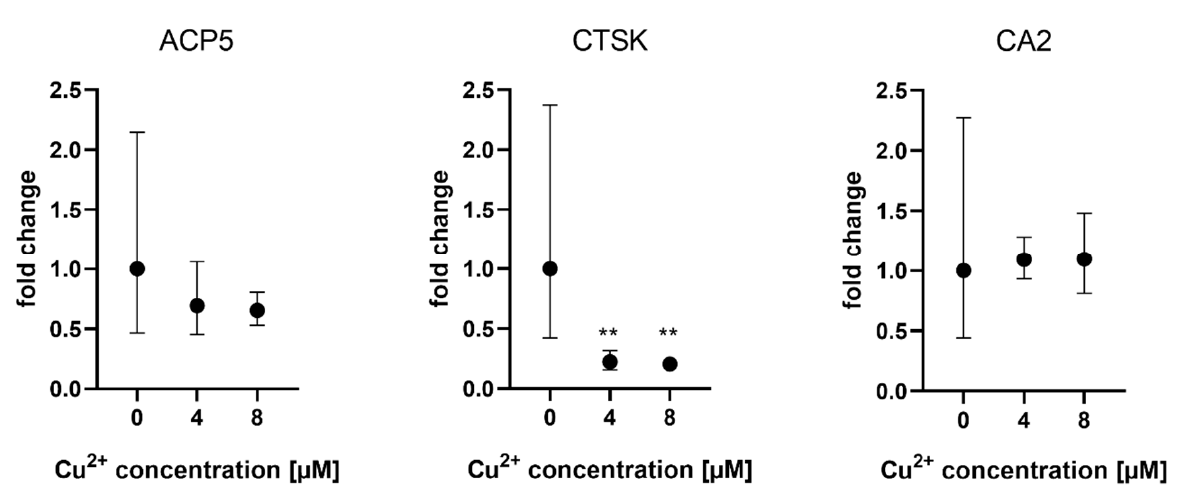
Figure 4. Expression of osteoclast marker genes in PBMC derived osteoclasts after 14 days of differentiation. Fold changes were calculated by the ∆∆ CT method and related to the samples without Cu 2+ . Samples of three different PBMC donors were used (each n = 3, n = 9 in total per group), mean ± upper/lower limit. Statistical differences were calculated from DCT values. ** p <